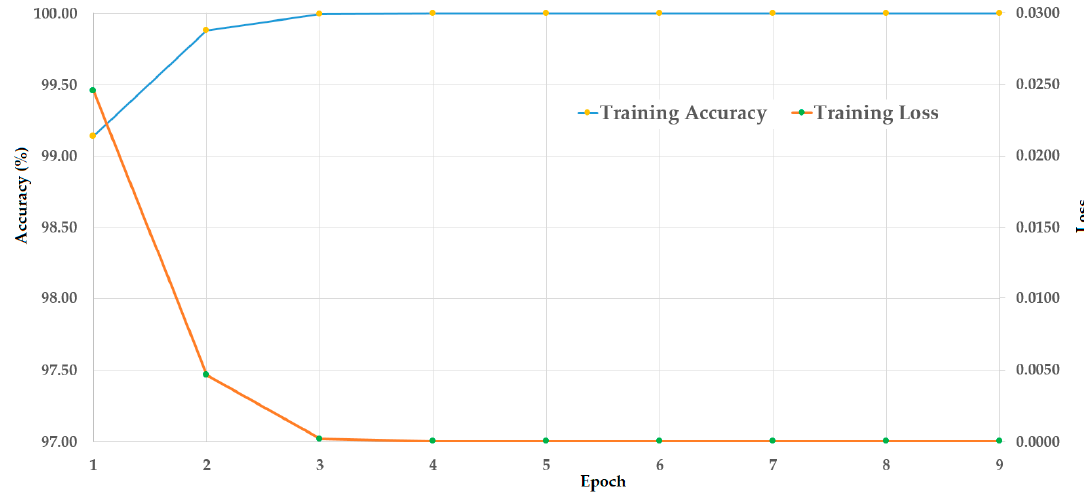
Figure 8. Convergence graphs (accuracy and loss) of the training procedure on the CASIA dataset.